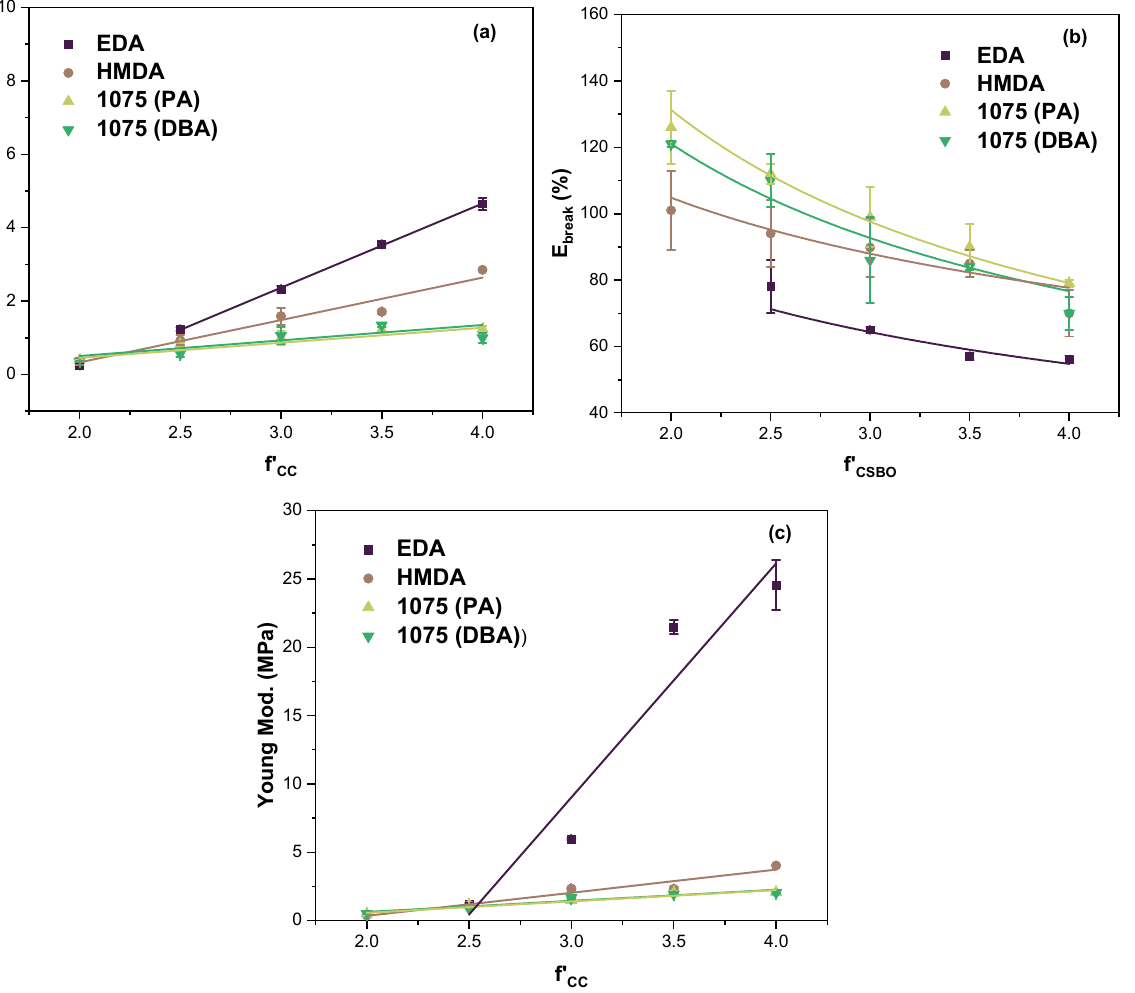
Figure 10. Tensile strength results (ASTM 412-D). ( a ) Stress at break, ( b ) elongation at break, ( c ) Young’s modulus.